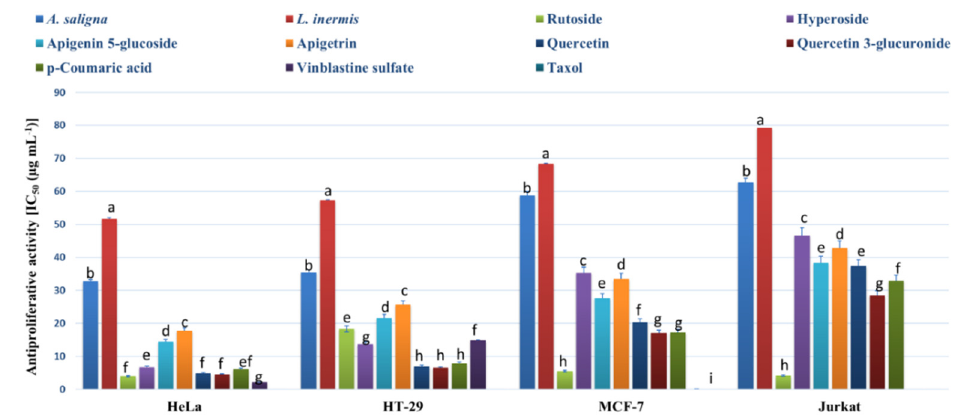
Figure 3. Antiproliferative activity (IC 50 ( μ g mL − 1 )) of A. saligna and L. inermis methanolic extracts, rutoside, hyperoside, apigenin 5-glucoside, apigetrin, quercetin and p- coumaric acid against cancer cells: cervical adenocarcinoma (HeLa), T-cell lymphoblast like (Jurkat), breast adenocarcinoma cultures (MCF-7), colon adenocarcinoma (HT-29) and HEK-293 (normal human cells). HEK-293 was not presented in the figure and showed IC 50 values > 400 μ g mL − 1 for all extracts and polyphenols. Different letters among group of columns indicate significant differences ( p ≤ 0.05).